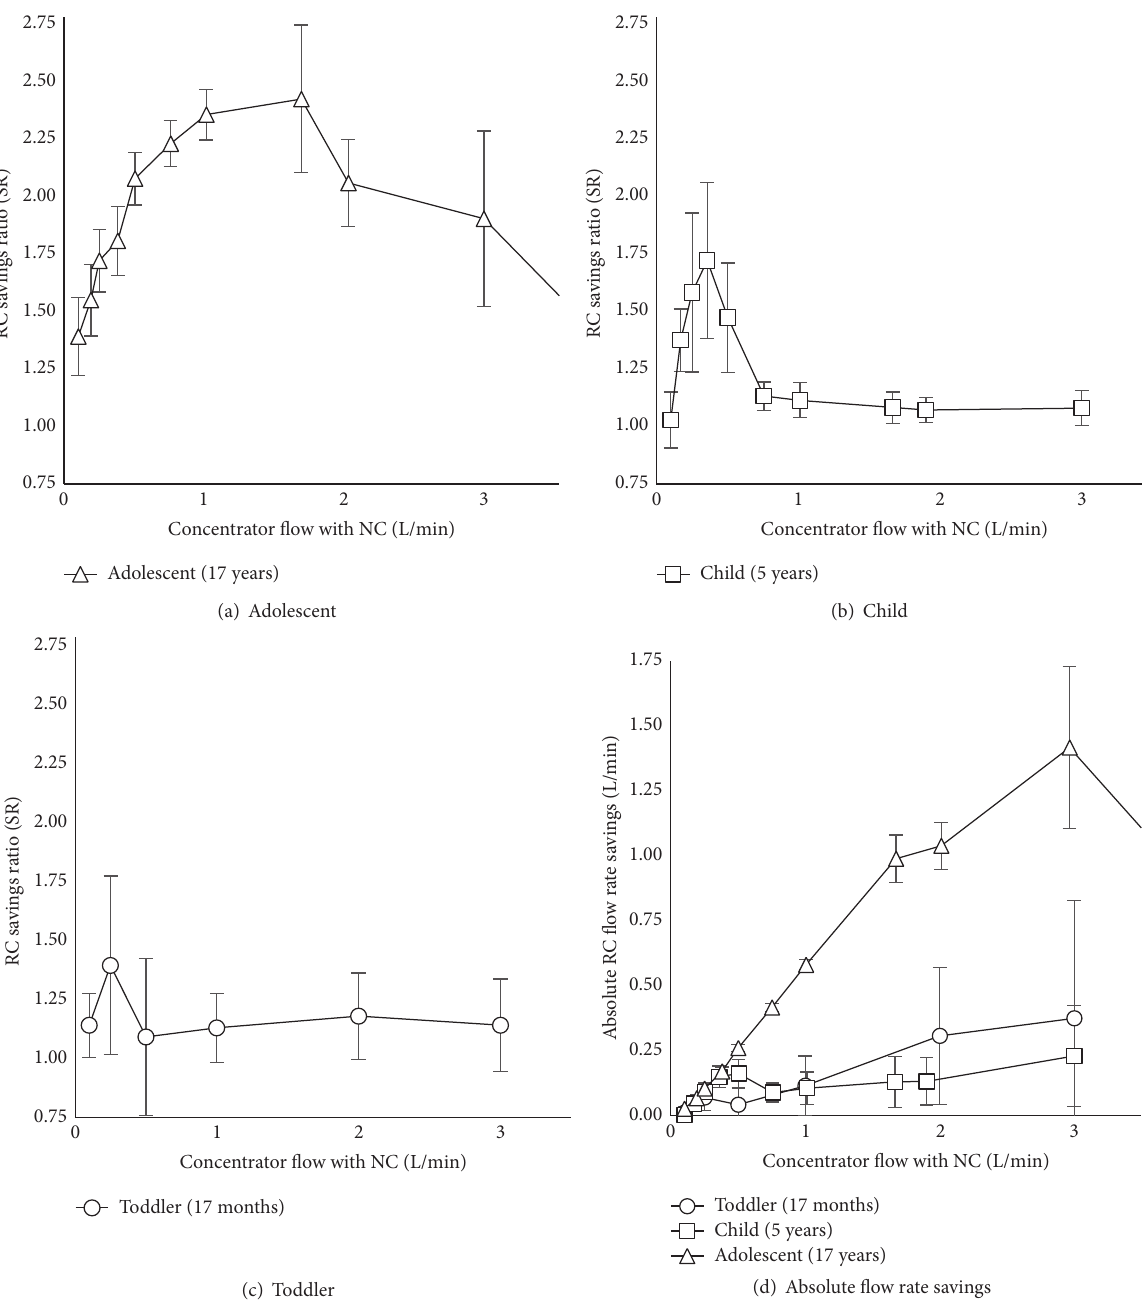
Figure 8: (a)–(c) Reservoir cannula (RC) oxygen savings ratio (SR) for three patient models and (d) absolute oxygen flow rate savings, compared to nasal cannula (NC) oxygen